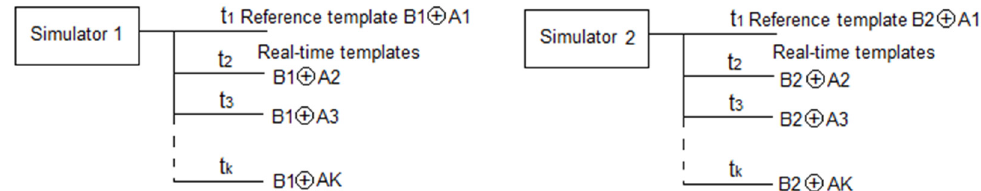
Figure 9. Formation of reference and real-time templates by two simulators, t i is the time of tem- plate formation.